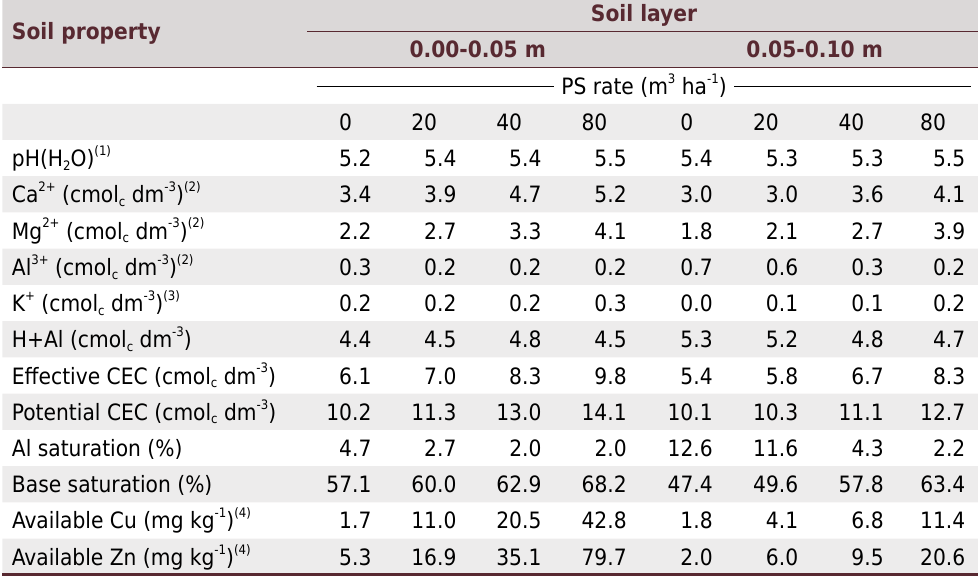
Table 2. Chemical properties of soil treated with 19 successive PS applications over 8 years, in Santa Maria, Rio Grande do Sul, Southern Brazil Soil